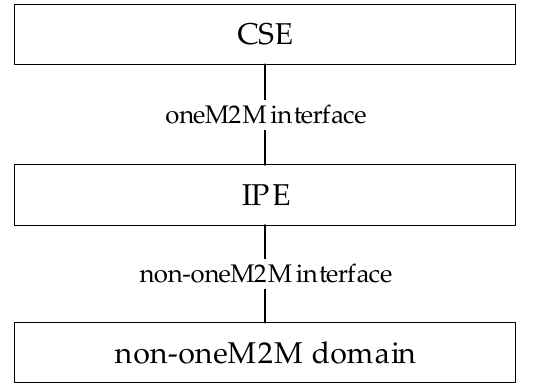
Figure 6. Interworking Proxy application Entity (IPE).